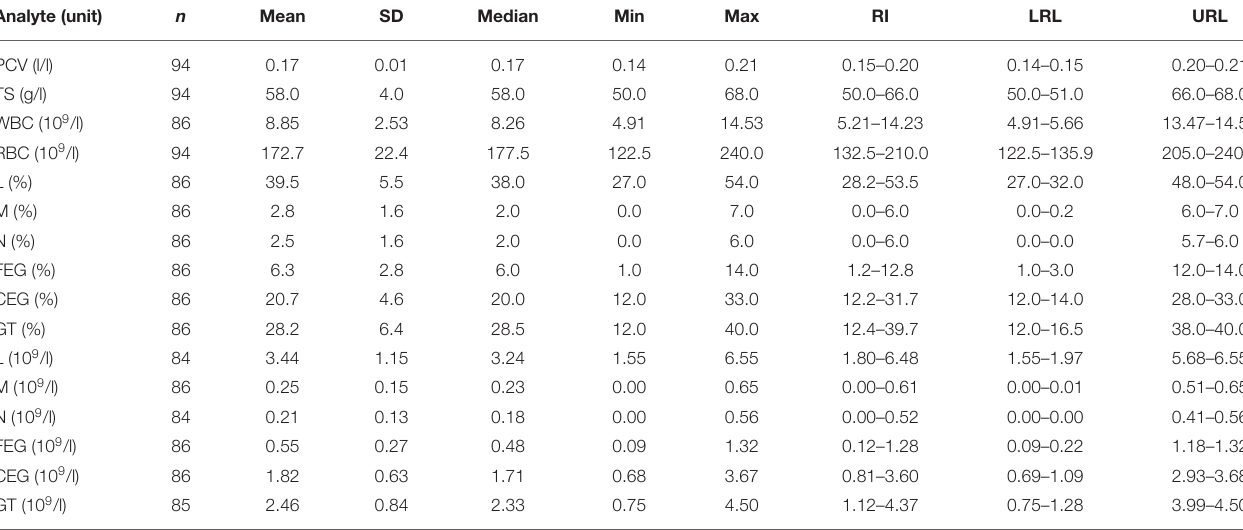
TABLE 2 | Hematology reference intervals for Nursehound Shark ( Scyliorhinus stellaris ) under human care. Analyte (unit)